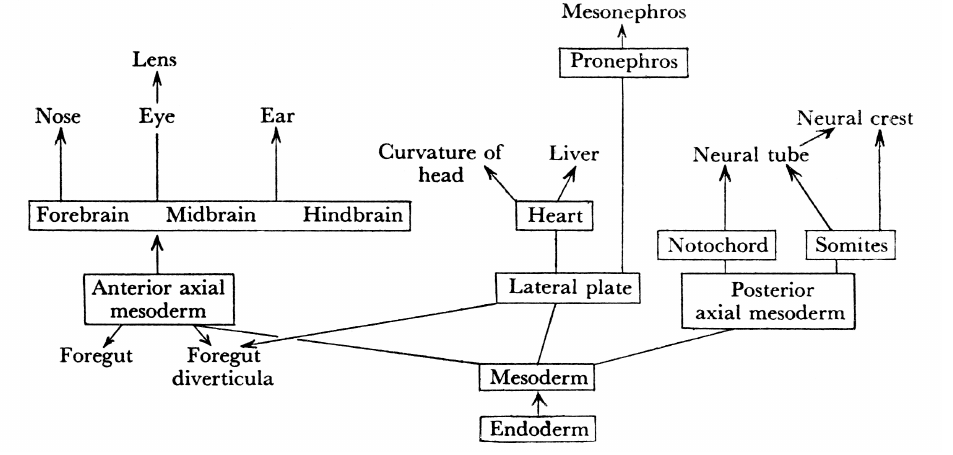
Organisers in the Chick , from Conrad H. Waddington, Organizers and Genes (Cambridge, UK: